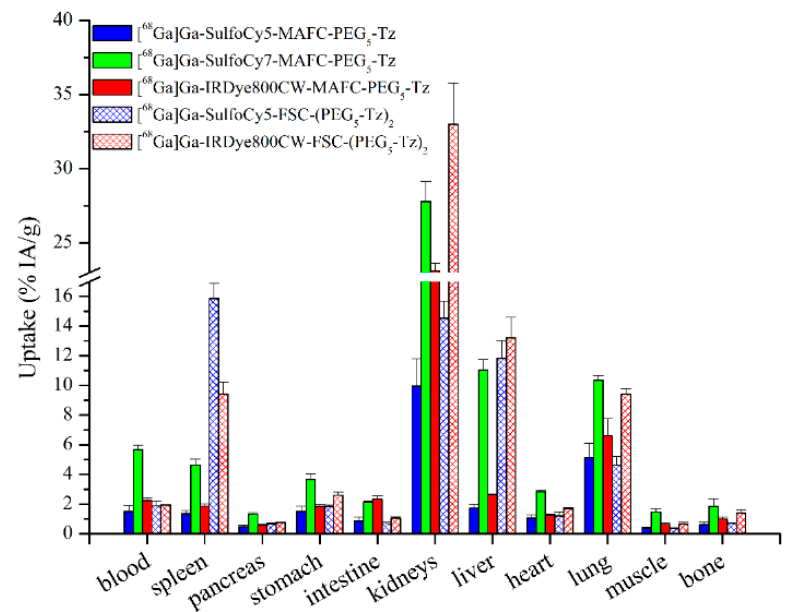
Figure 4. Ex vivo biodistribution profile studies of 68 Ga-labeled FSC-based Tz-bearing dual-modality imaging agents in healthy BALB/c mice 1 h after administration.